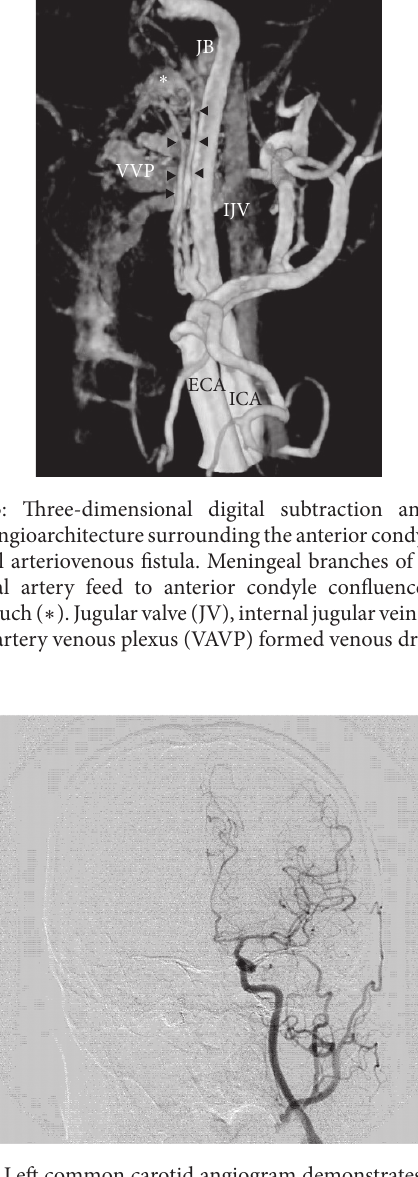
Figure 4: Left common carotid angiogram demonstrates complete obliteration of anterior condylar confluence dural arteriovenous fistula.